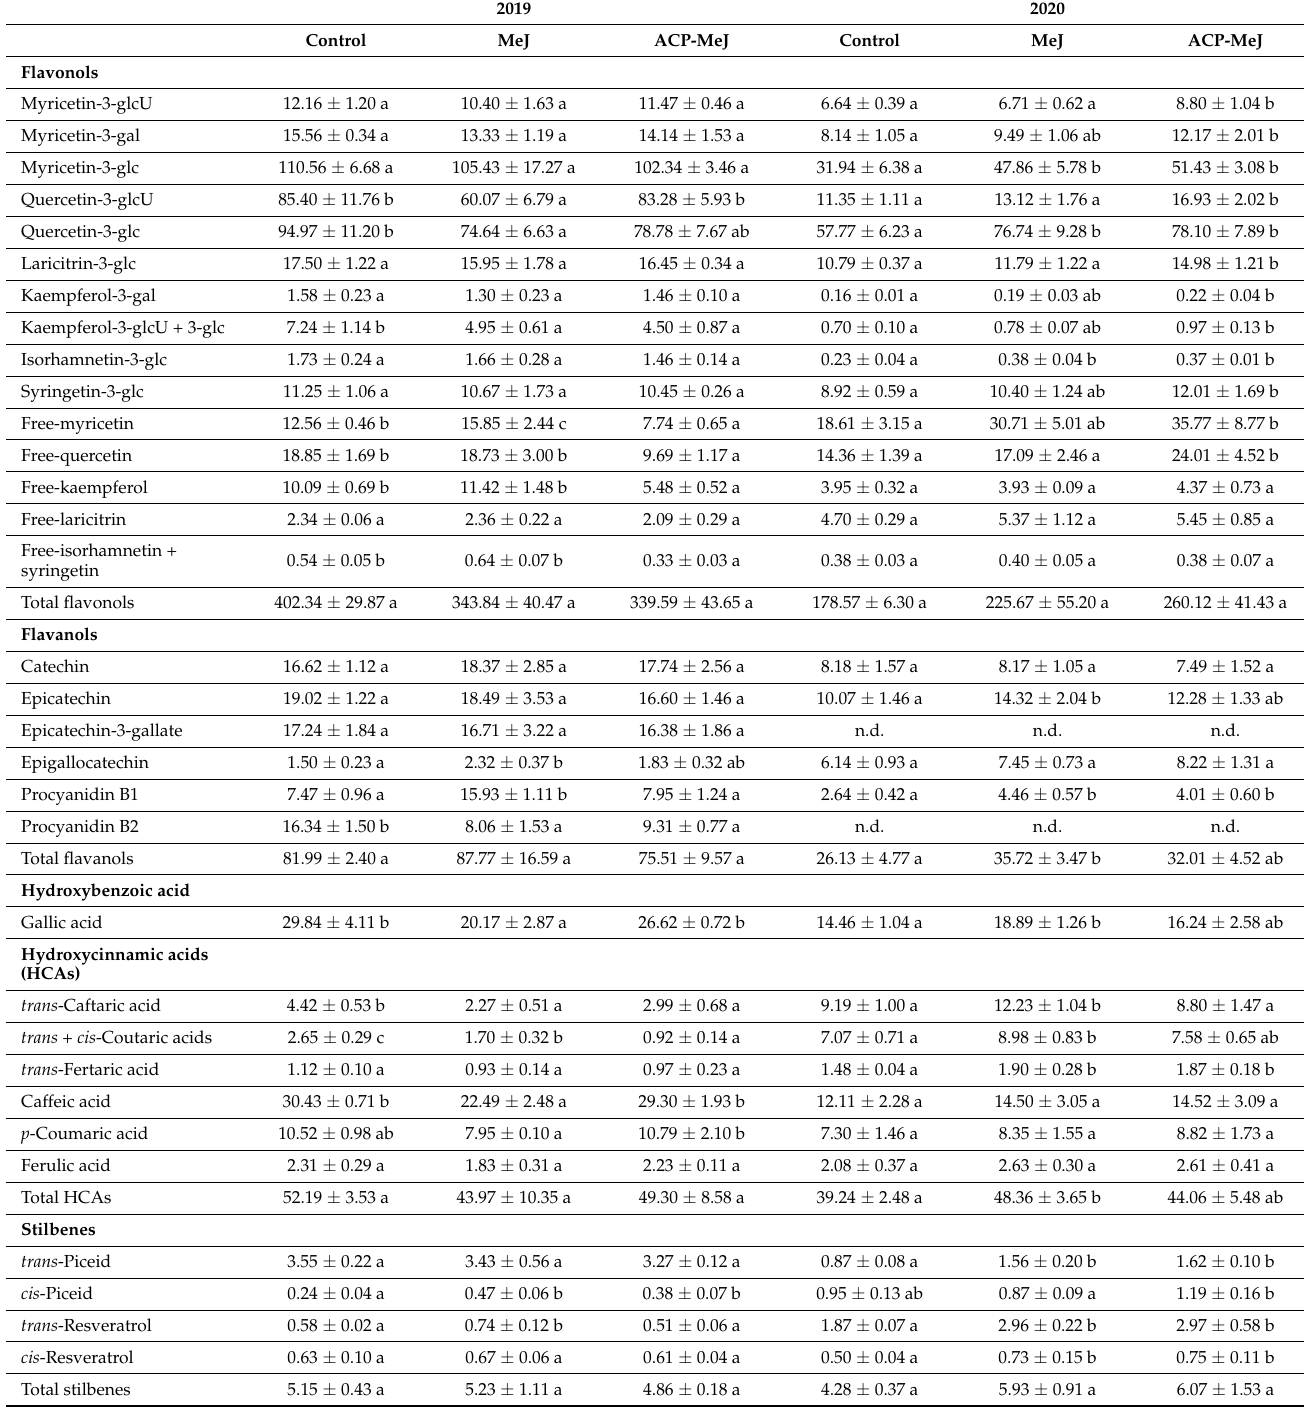
Table 3. Flavonols, flavanols, phenolic acids and stilbenes content (mg/L) in wines from control, methyl jasmonate (MeJ) and nanoparticles doped with this elicitor (ACP-MeJ) treatments, in 2019 and 2020